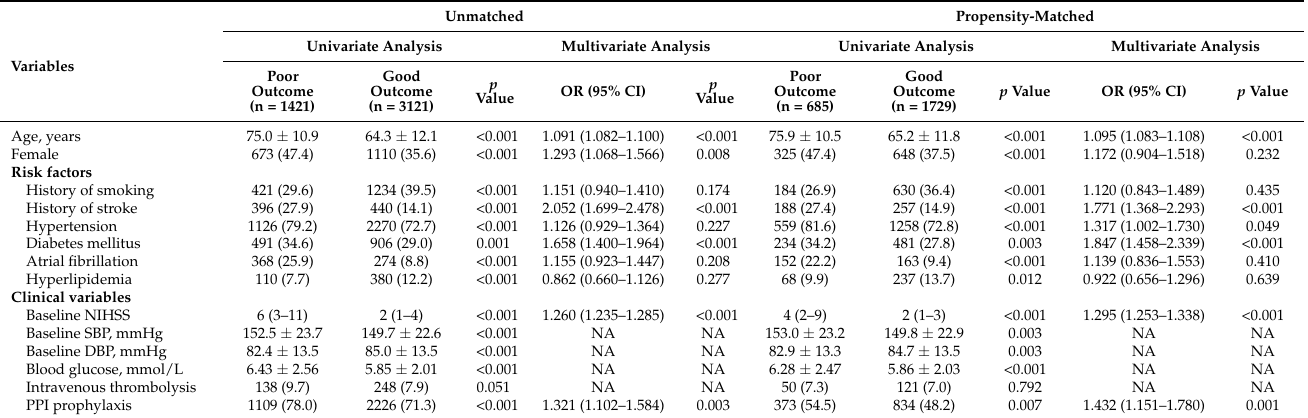
Table 2. Univariate comparison and multivariate analysis for poor outcome at one year in unmatched and propensity-matched